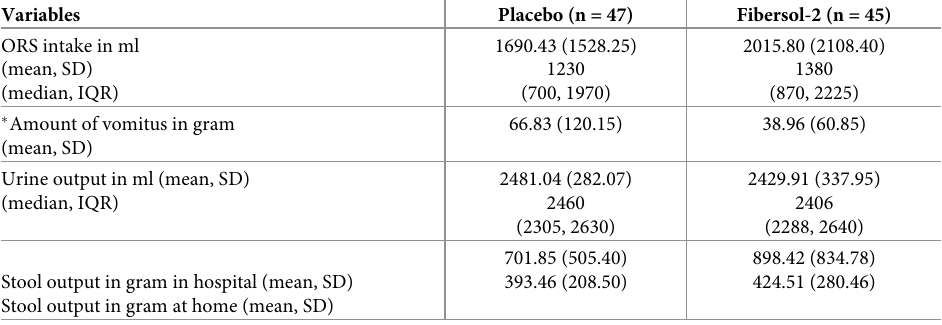
Values were expressed as mean (SD), (median, IQR); SD, Standard deviation; IQR, Inter quartile range; ORS, Oral rehydration solution. � Only 21 children in group A and 19 children in group B had vomiting.